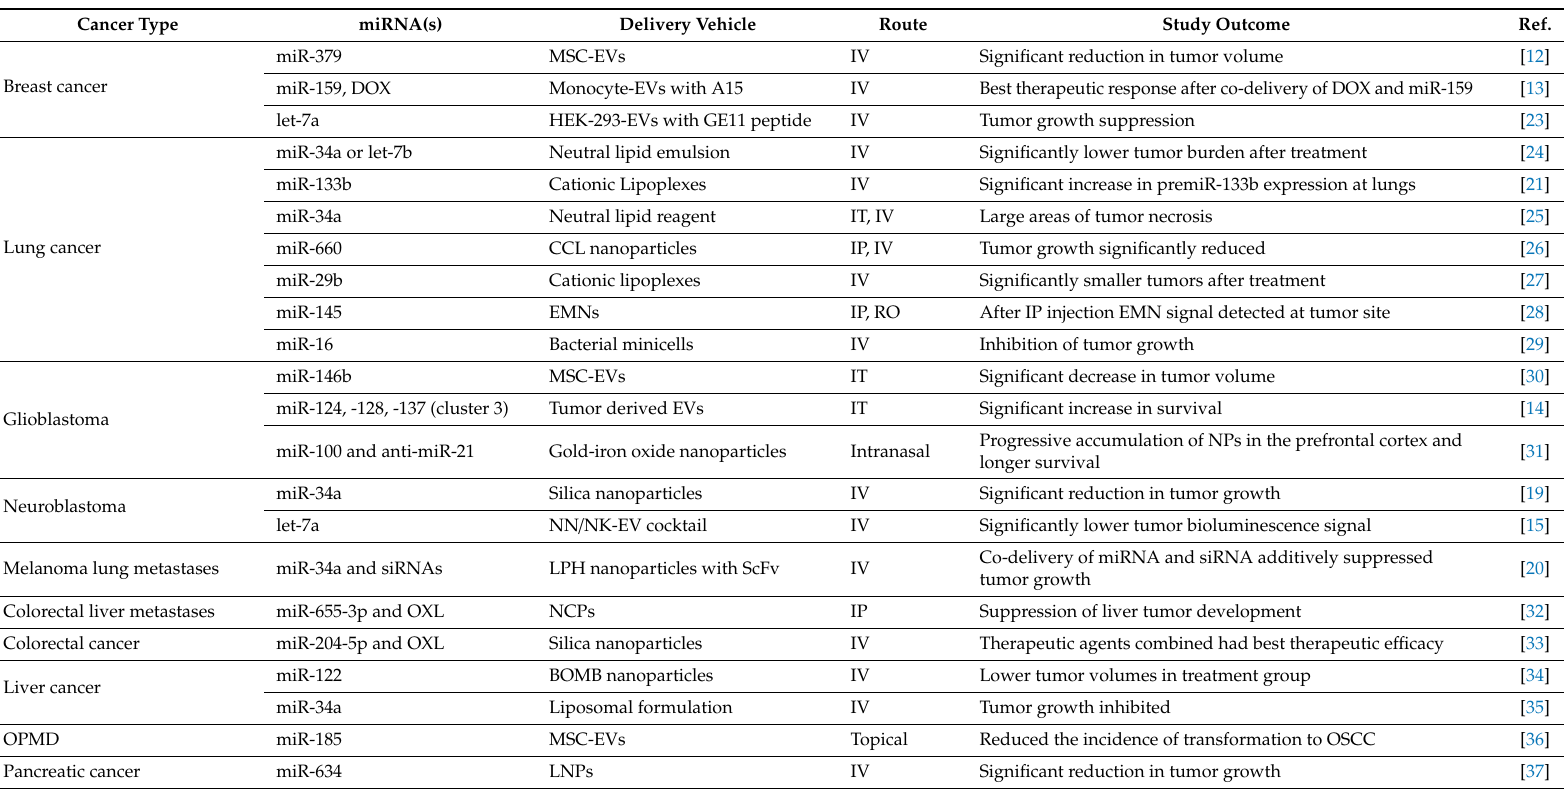
Table 1. Pre-clinical studies utilising various nanoparticle formulations to deliver tumor suppressor miRNA. Intravenous (IV), intratumoral (IT), intraperitoneal (IP) retro-orbital (RO), doxorubicin (DOX), oxaliplatin (OXL), protein A disintegrin and metalloproteinase 15 (A15), human embryonic kidney 293 cells